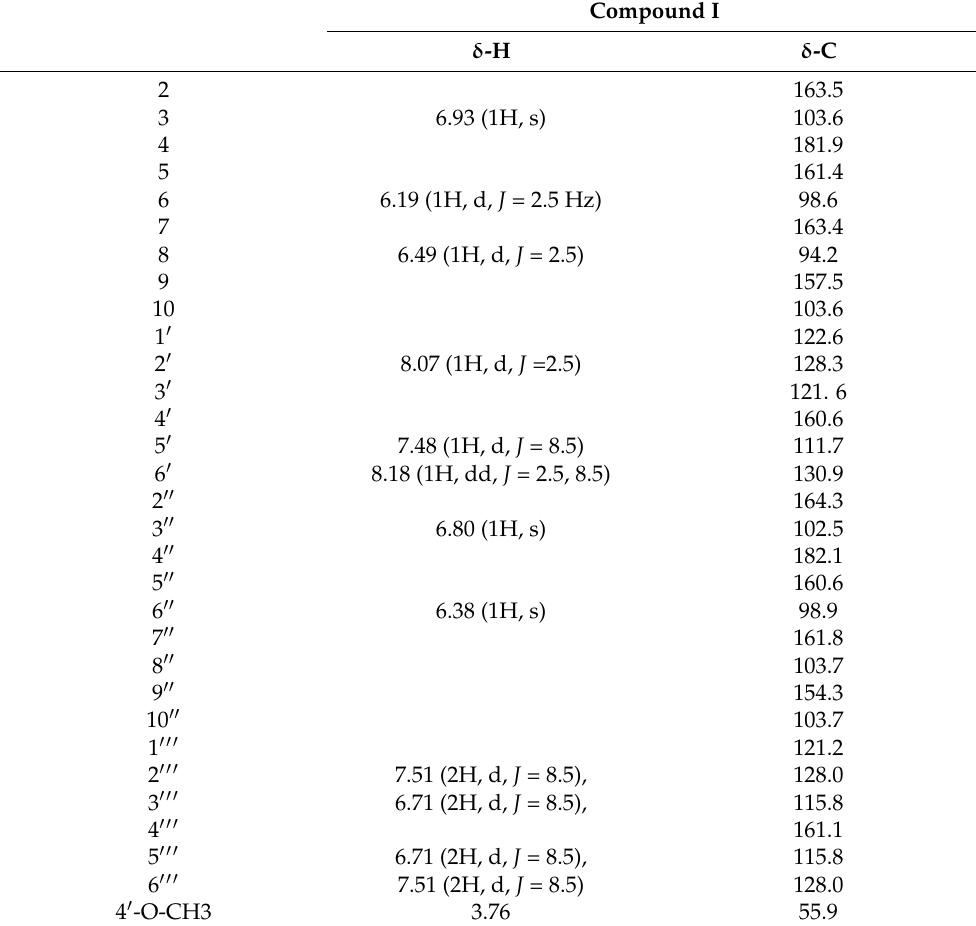
Table 2. Effects of Bilobetin treatment on testis/body weight ratio in Cisplatin-induced testicular toxicity in rats.